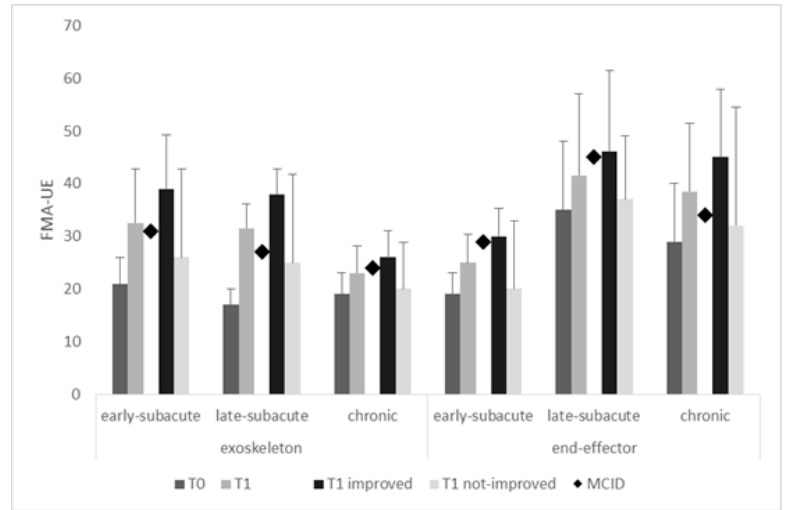
Figure 2. Fugl-Meyer Assessment for the upper extremity (FMA-UE) in the different subgroups at T0 and T1 (data from all the participants as well as from improved and notimproved patients). T1–T0 comparisons were significant (all p < 0.0001) only in all patients grouped together and in the improved patients (i.e., those who achieved the MCID). The vertical error bars refer to SD. Minimal clinically important difference, MCID.